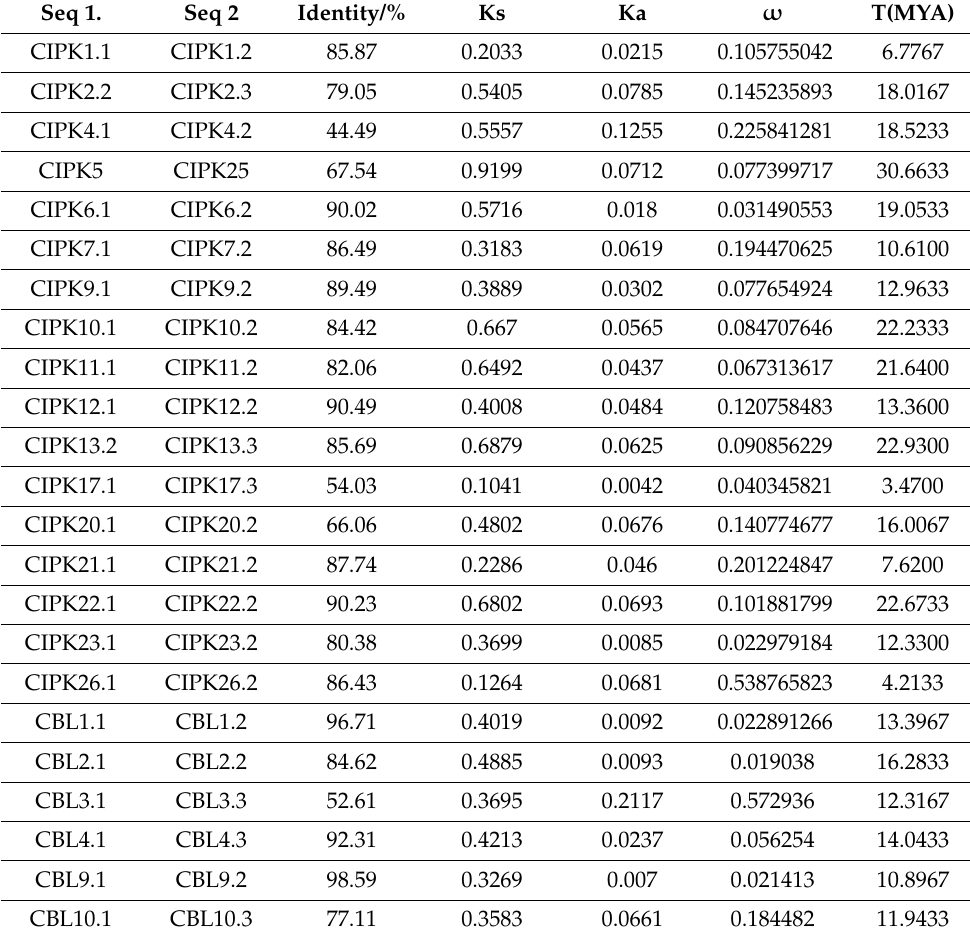
Table 3. Inference of divergence time in paralogous